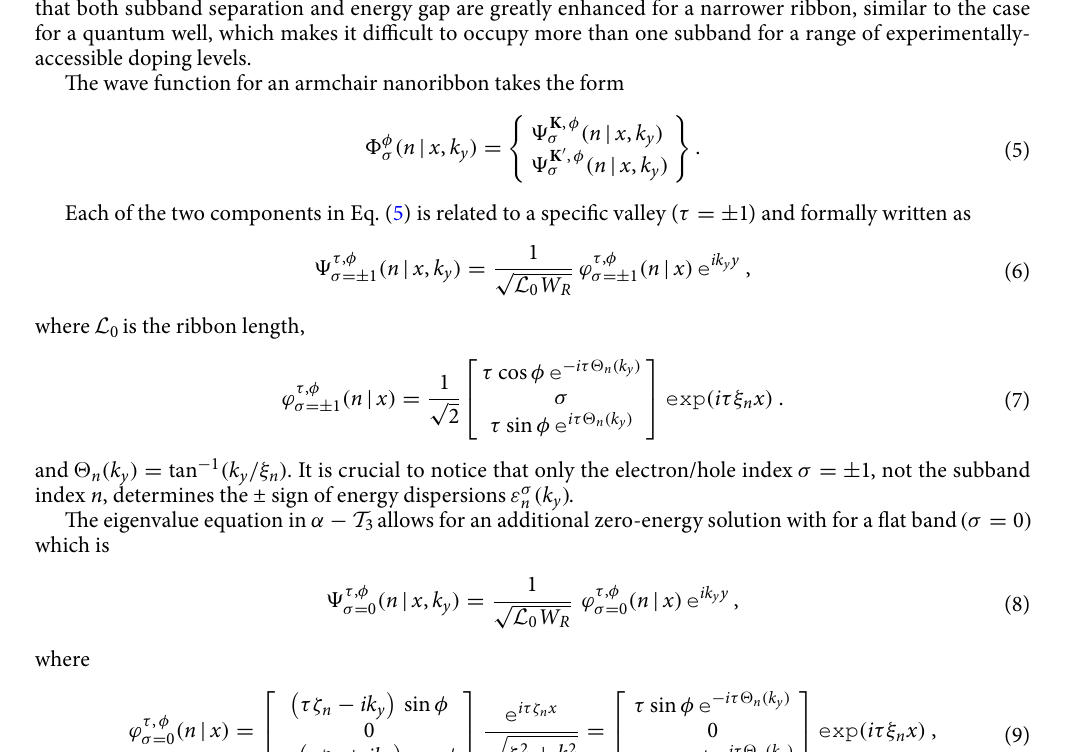
T 3 armchair nanoribbons with different widths − 49, 50, 51 atomic rows, respectively. Panel ( d ) shows the = ( 0 ) 1 , 1.57 10 8 m (π/ 2 ) ( 10 8 m − 1 ) − F = = ×